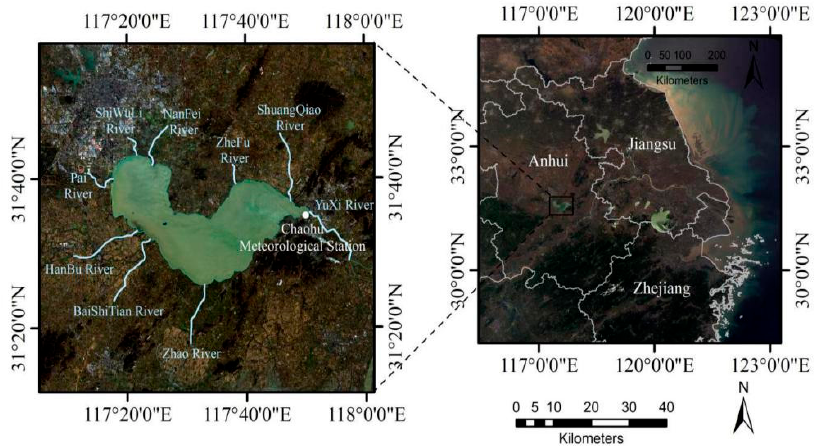
Figure 1. Location of Chaohu Lake.